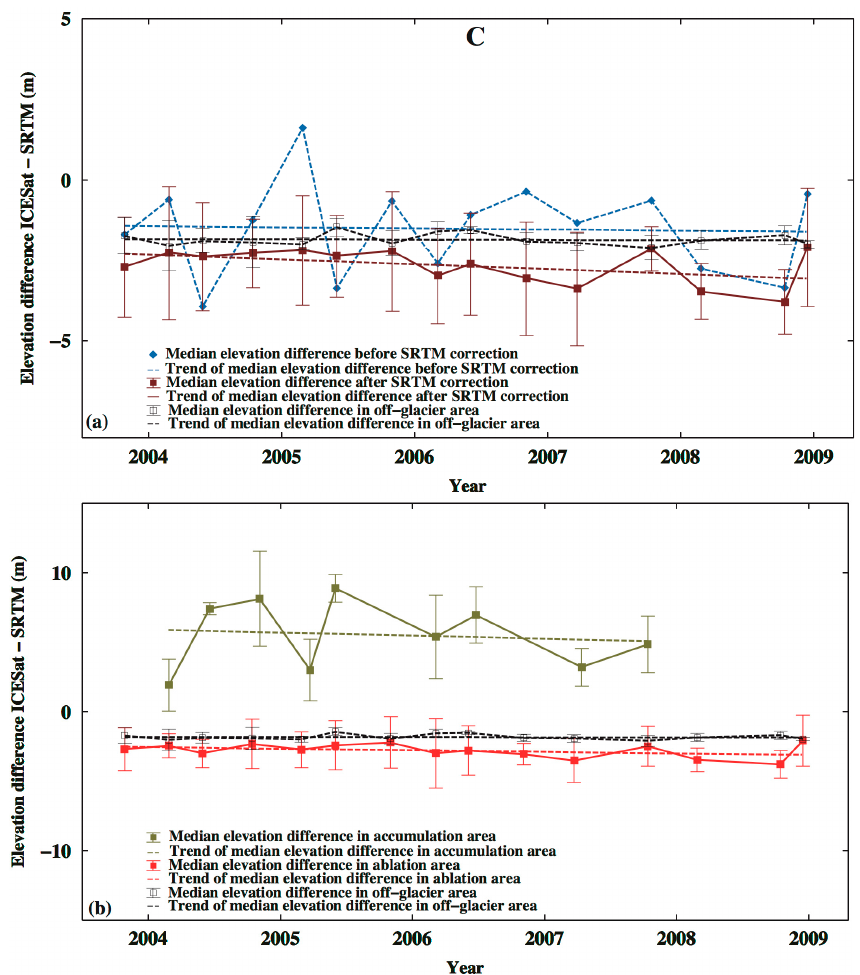
Figure 5. Same as Figure 4, but for Region C only. The rates are determined ( a ) in Region C using corrected and uncorrected SRTM elevations and ( b ) in the accumulation and ablation areas using corrected SRTM elevations.